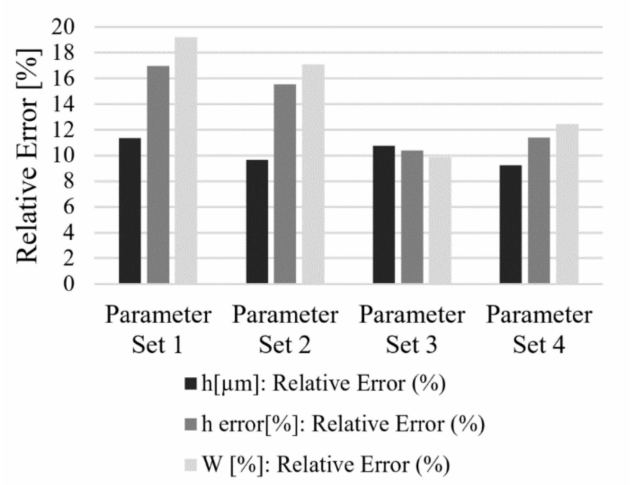
Figure 11. Bar charts summarizing relative error between model-predicted and verification experiments with parameter sets: ( 1 ) F = 5.69 J / cm 2 , P O = 95.86%, H D = 52%, ( 2 ) F = 6.4 J / cm 2 , P O = 95.86%, H D = 52%, ( 3 ) F = 5.69 J / cm 2 , P O = 95.86%, H D = 76%, and ( 4 ) F = 6.4 J / cm 2 , P O = 95.86%, H D =